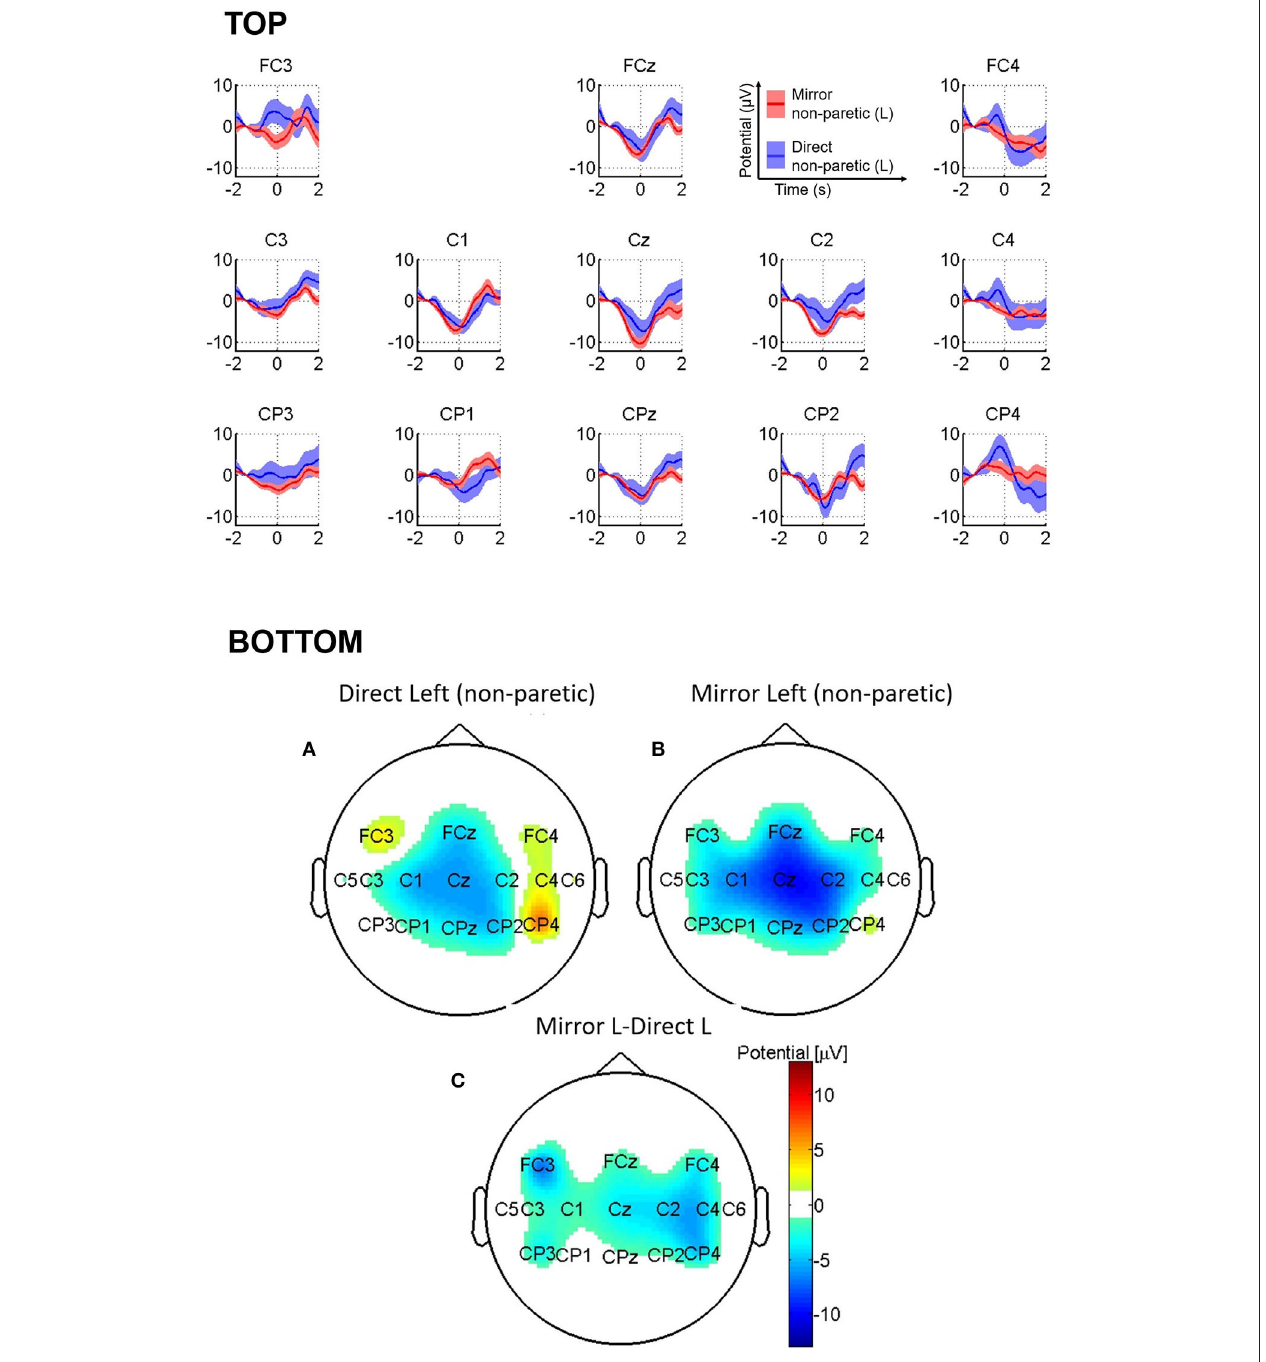
FIGURE 4 | (Top) Grand-average MRCPs of the stroke participant for direct left (non-paretic) and mirror left (non-paretic). The shaded area represents standard error of the mean (SEM) computed separately. (Bottom) Topographic image of stroke participant’s average MRCPs in the window ( − 225 to –200) ms for (A) direct left (non-paretic) and (B) mirror left (non-paretic) , and (C) the difference between mirror left (non-paretic) and direct left (non-paretic) conditions.